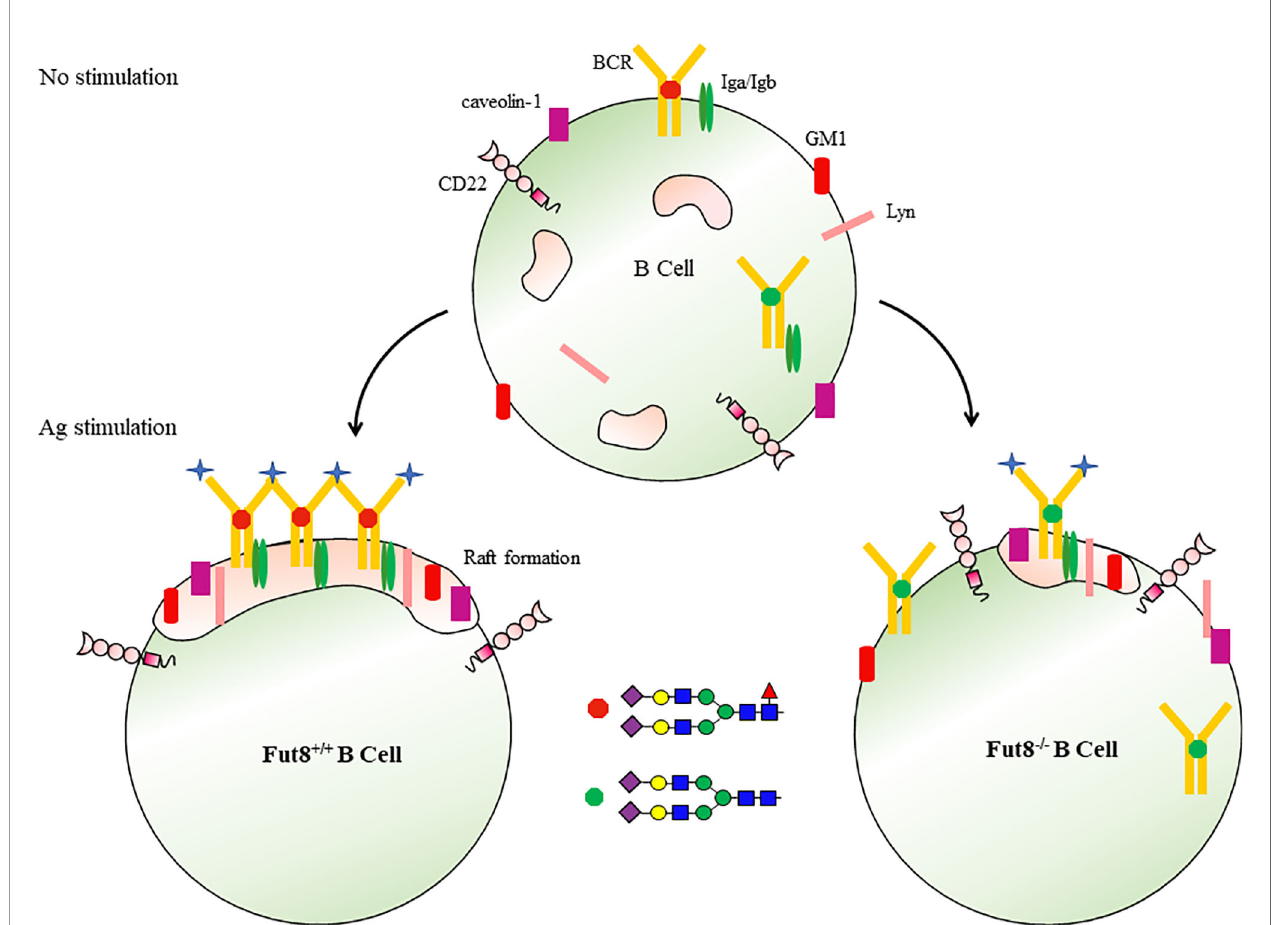
FIGURE 4 | Core fucosylation regulates the signal transduction via BCR. Upon Ag engagement, BCRs on the surface of B cells associated with lipid rafts and triggers signal transductions required for the activation of B cells. Core fucosylation promoted B cells to form a highly ef fi cient lipid raft domain, thereby regulating signal transduction via